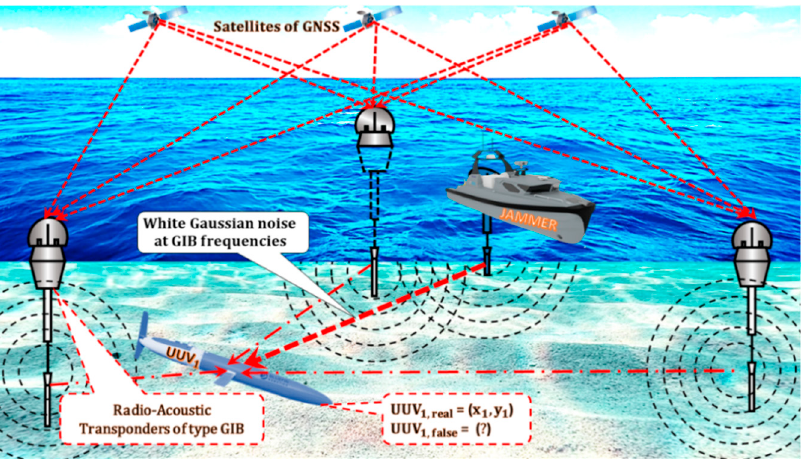
Figure 11. The LNSS basic jamming scheme of UUVs: at some point in time, the jammer transmits white noise at GIB frequencies, which aims to make a PVT solution impossible. All UUVs in the jammed area lose orientation UUV false = (?).